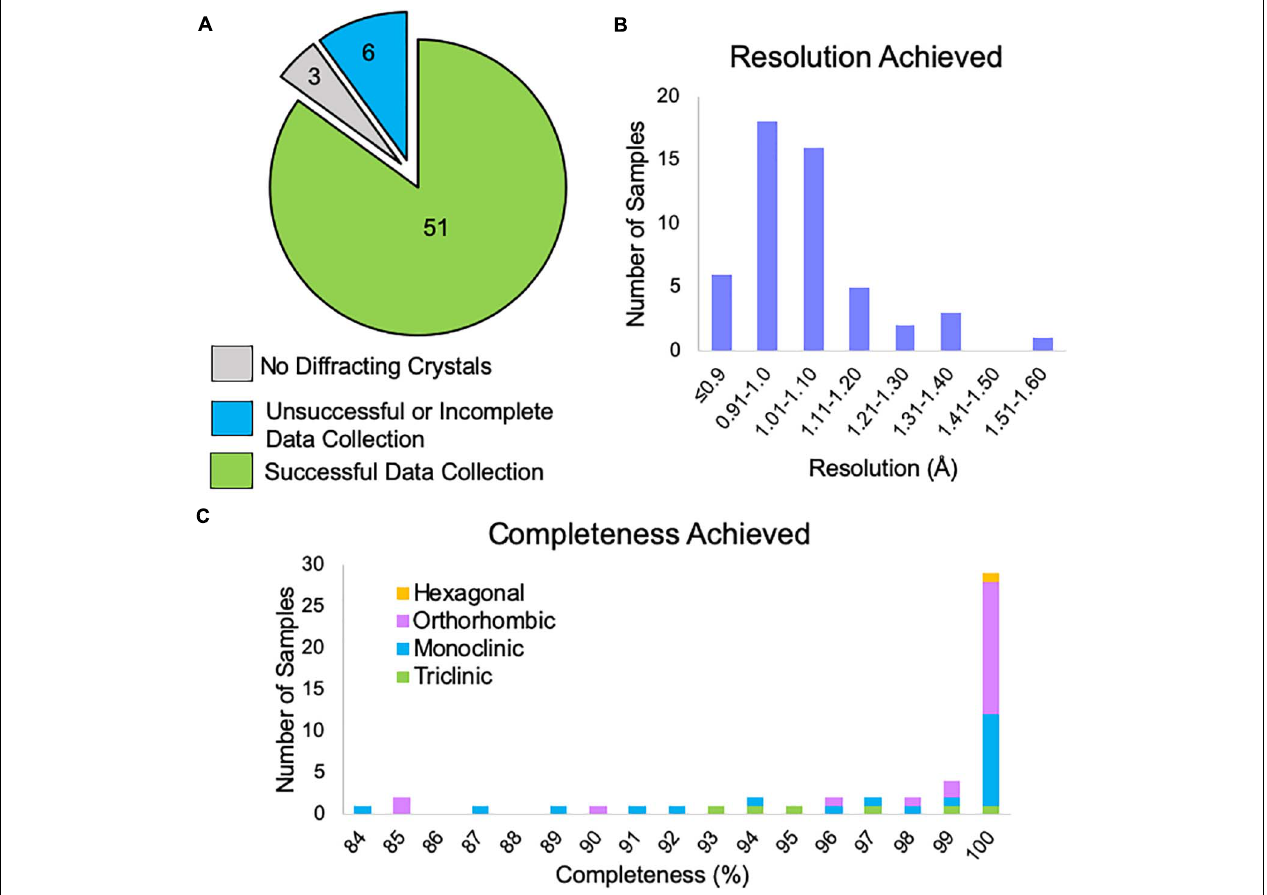
FIGURE 6 | (A) The outcome of MicroED data collection at NIS for client and internal samples (progesterone, biotin, paracetamol, and teniposide). Three samples did not contain diffracting crystals, but we note that XRPD pre-screening was not performed for these samples prior to submission. Six samples did not yield enough data suitable for structure solution and likely need additional microscope time, possibly with an alternative grid preparation method. Fifty-one samples produced data that should be sufficient for structure solution. (B) For the 51 successful data collections, the approximate resolution limits are shown. This resolution estimate is based on automated processing results from DIALS for the highest resolution crystal. This value is based on CC 1 / 2 ≥ 33%. We note that the final resolution after processing by a trained crystallographer may differ from this cutoff. (C) Of these data collections, the overall completeness based on combining all crystals is shown broken down by Bravais lattice type. Automated processing in DIALS was carried out in the space group suggested by dials.cosym with all crystals for which integration was successful. Overall completeness is shown to the resolution limit determined in panel (B) . The single hexagonal sample was in space group P6 4